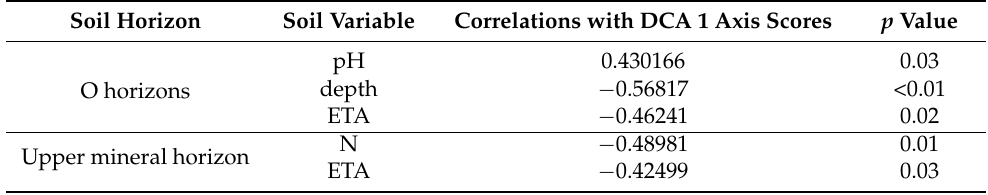
Table 5. Pearson’s correlation of soil variables with DCA axis 1 scores (only significant correlations are